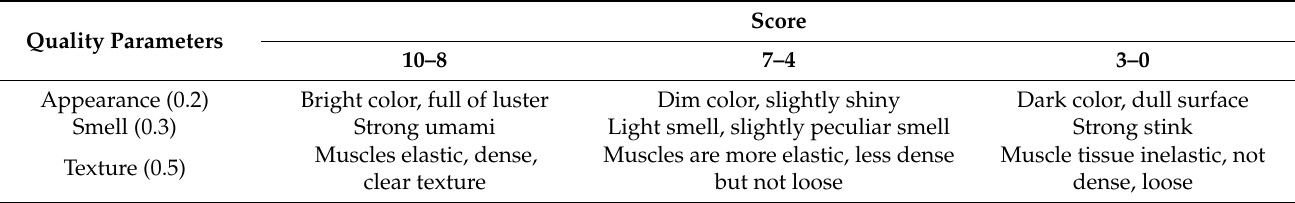
Table 1. Sensory scoring of sea bass